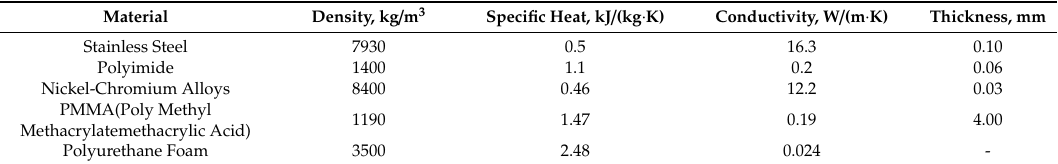
Table 2. Material